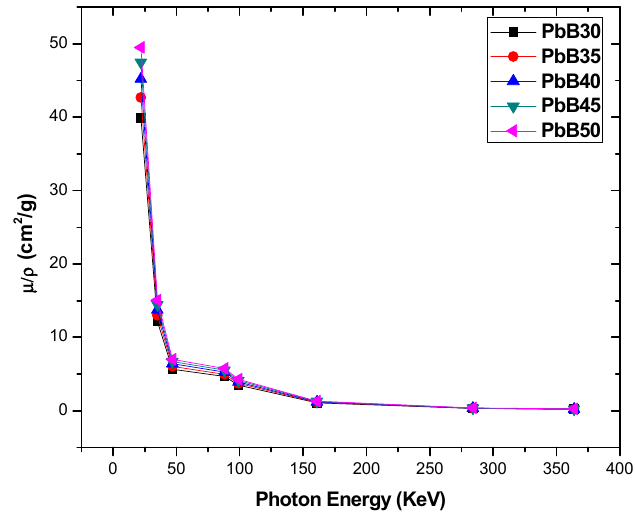
Figure 2. The mass attenuation coefficient of the investigated glass samples.